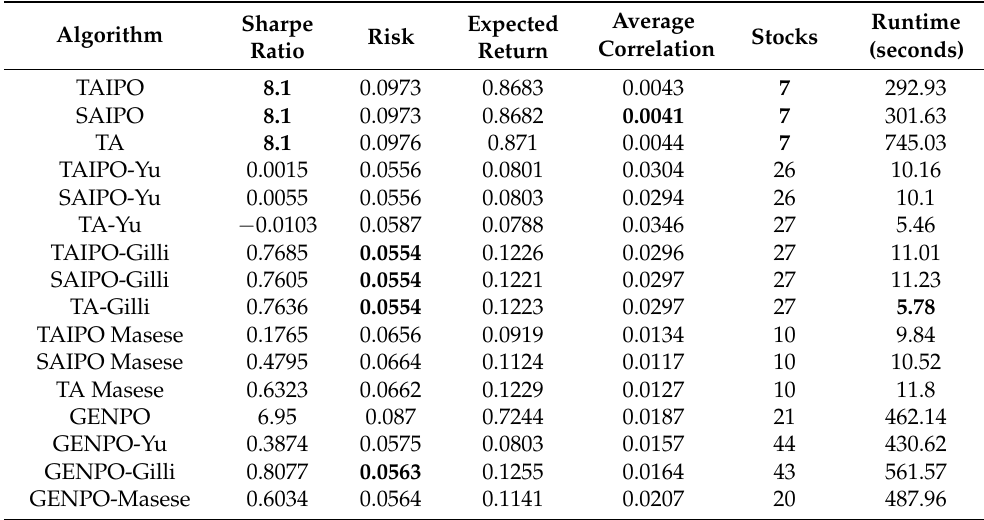
Table 3. Algorithm performance without MARR